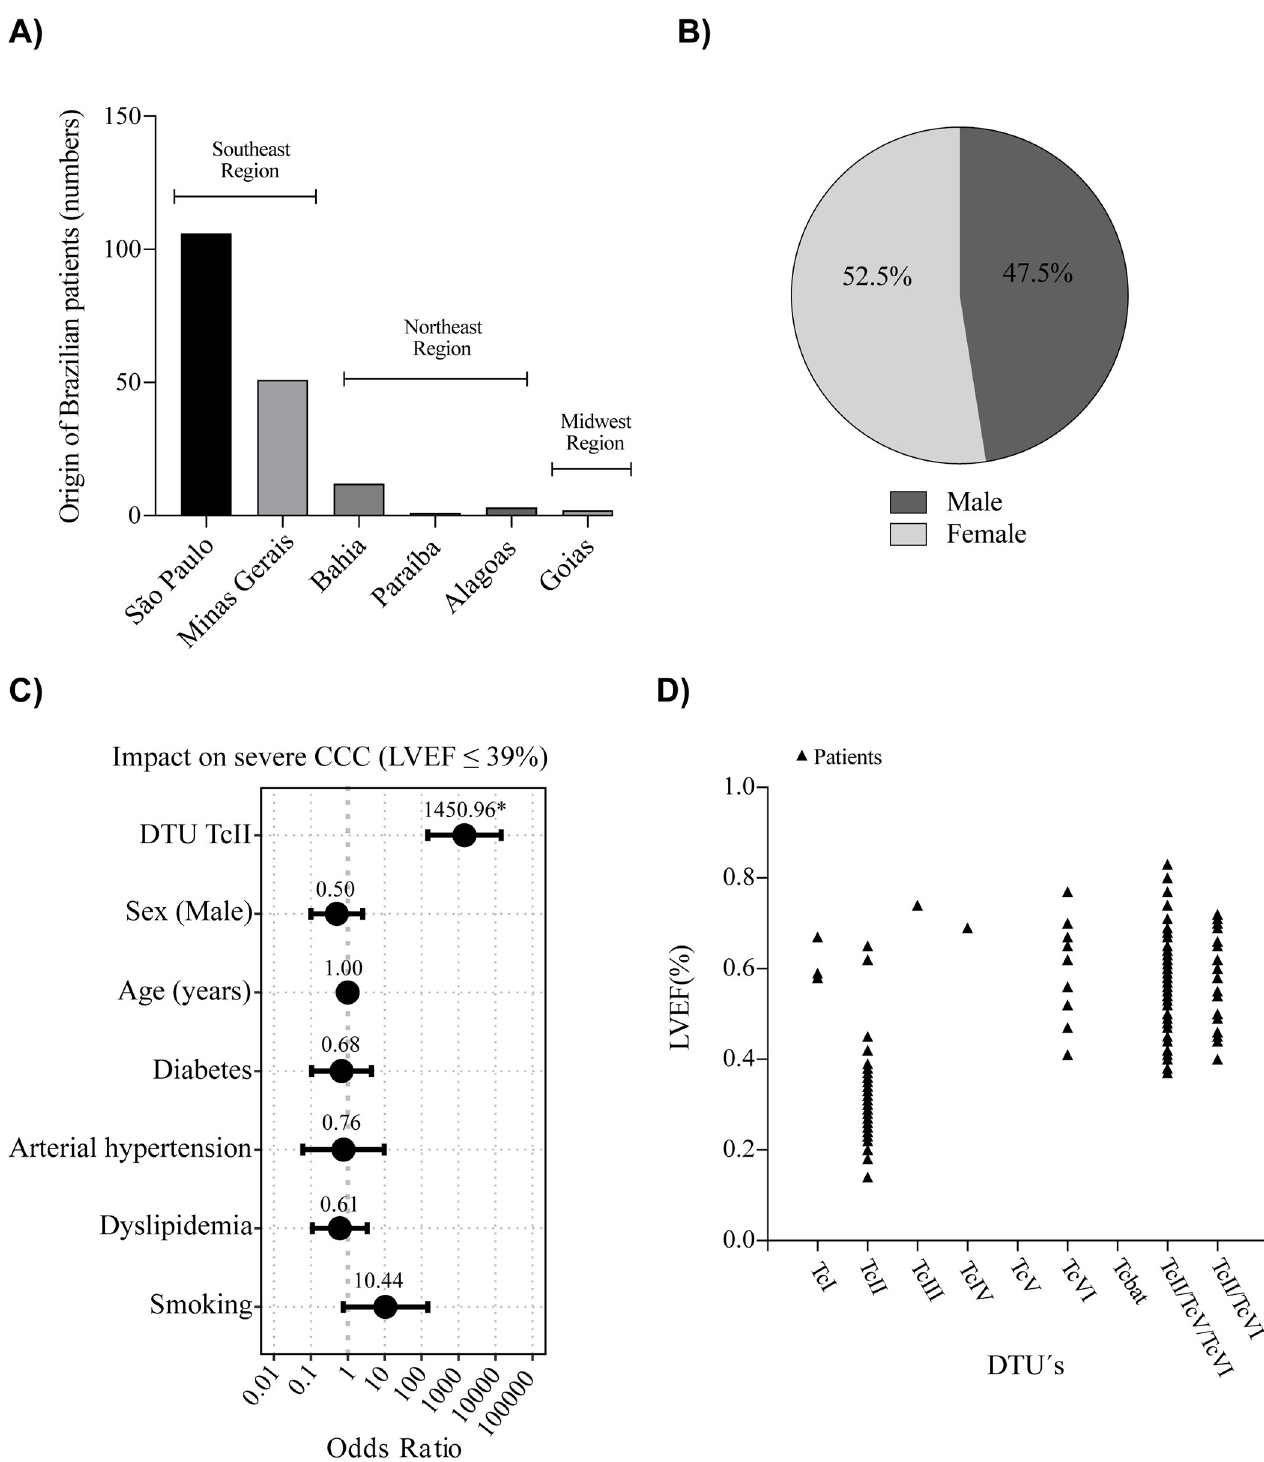
Fig 1. A) Geographical origin of each patient (Brazilian States and regions); B) Sex Male or Female; C) Multivariate logistic regression correlating the impact of gender, age, cardiovascular risk factors and T . cruzi genotype on the occurrence of severe CCC. D) Left ventricular ejection fraction according to different T . cruzi